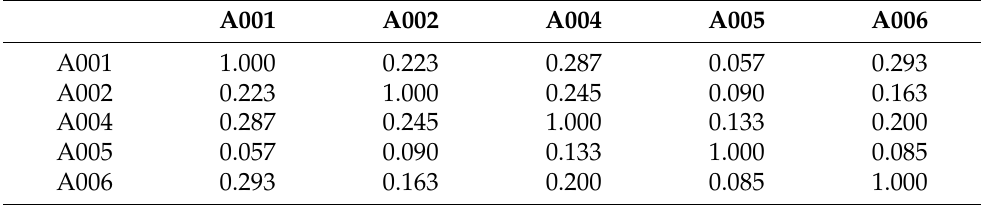
Table 6. Inter-annotator agreement for Round-4 annotation of 1079 images